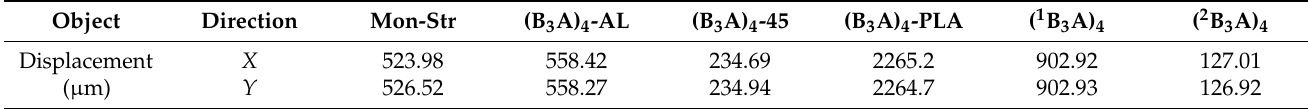
Table 3. Analysis results of different decoupled parallel XY MPSs.